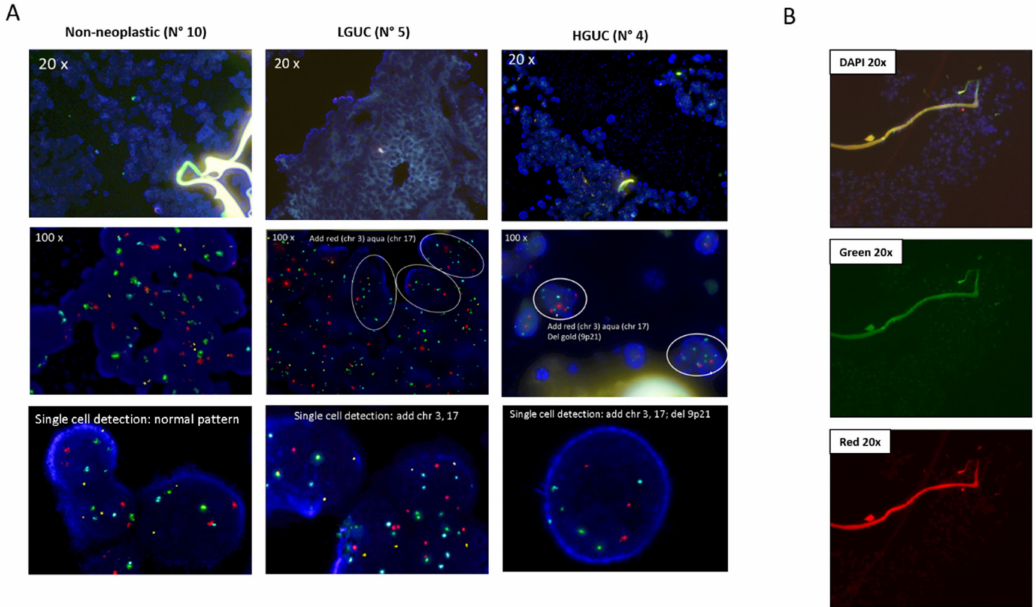
Figure 3. UroVysion FISH on CytoMatrix-FFPE blocks. ( A ) Panel of FISH at magnification 20x, 100x and single cell detection from different representative cases diagnosed as non-neoplastic (N ◦ 10), LGUC (N ◦ 5), and HGUC (N ◦ 4); images evidence the presence of 3 or more signals for chr 3 (red) and chr 17 (aqua) in >10% cells in tumor samples, and the HGUC shows also homozygous deletion of 9p21 (gold). ( B ) Autofluorescence of the CytoMatrix fibers with DAPI, Green, and Red filters (at magnification 20 ×